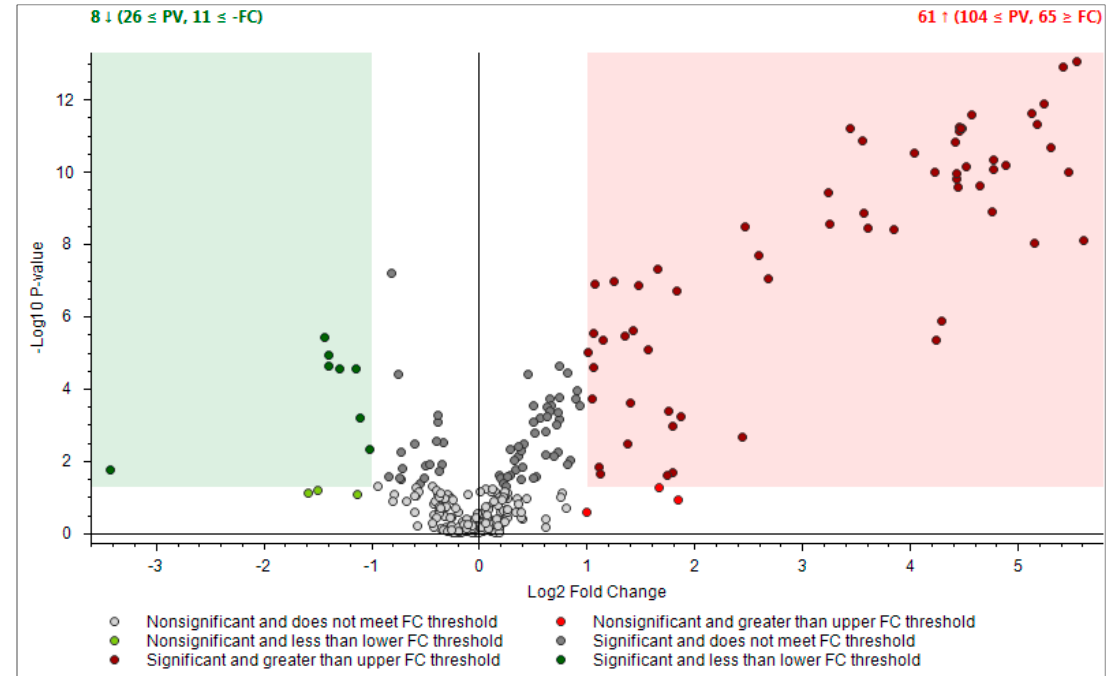
Figure 5. Differential analysis presented by Volcano Plot Model for the comparison between the relative intensity of chromatographic peak from two propolis groups. P -value (PV) was set on 0.05. Red region contains up-regulated signal where the quantities from Apennines was significantly higher than those found in Po Valley samples and was greater than the upper fold-change (FC) threshold. The green region comprises up-regulated peaks in Po Valley samples.